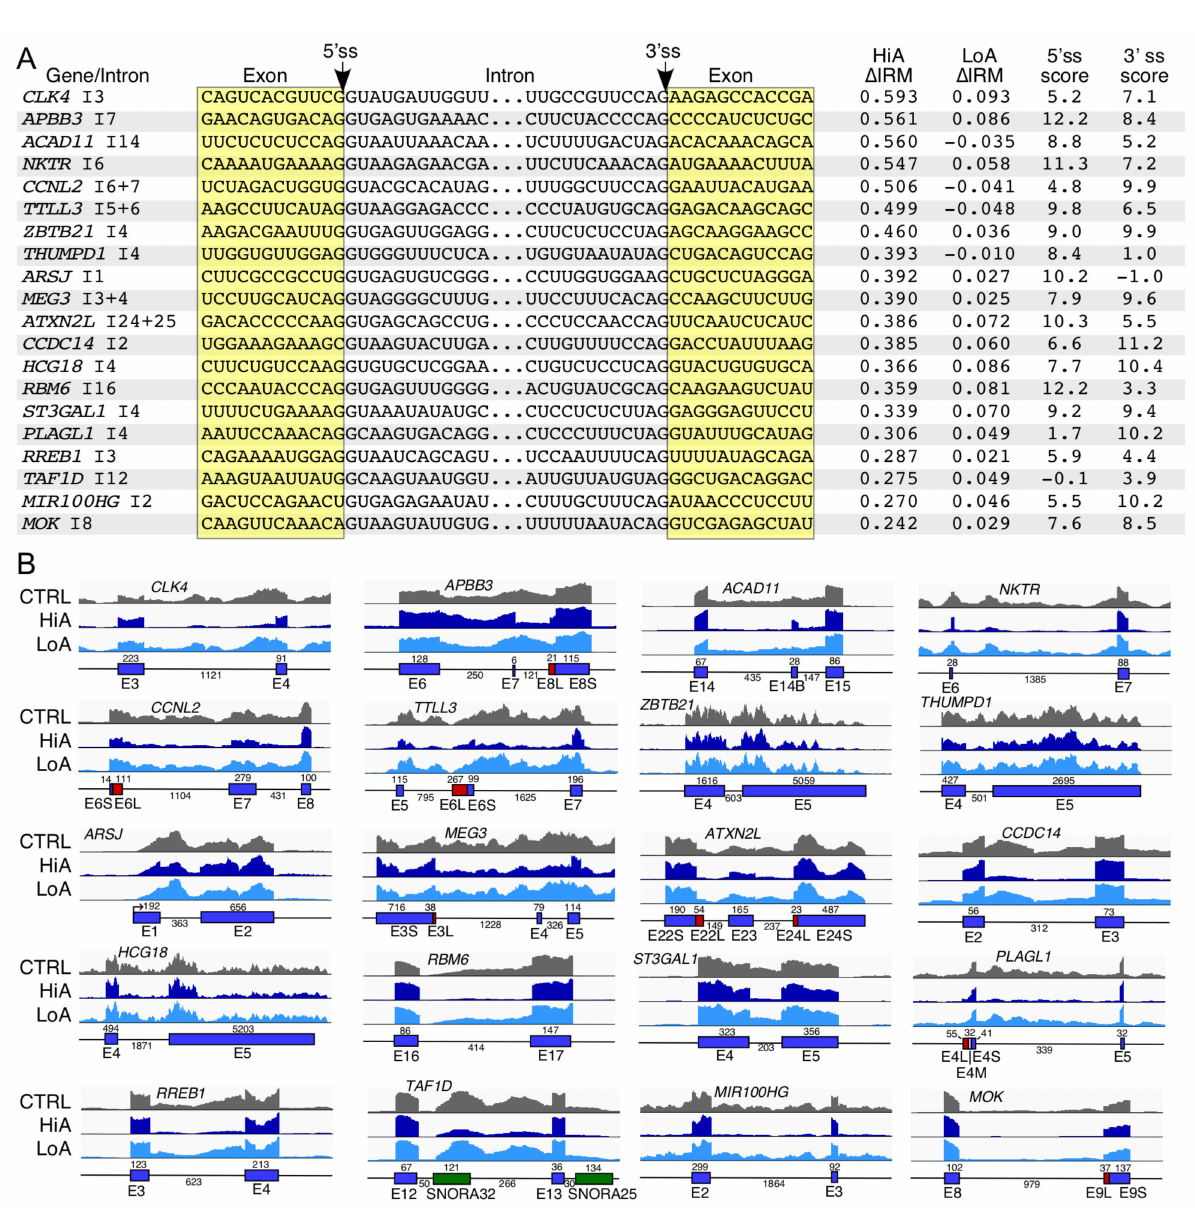
Figure 6. Increased intron removal caused by Anti-N1 treatment. ( A ). The sequence context of 20 candidate introns exhibiting greatly increased removal upon Anti-N1 treatment; 12 nucleotide-long sequences upstream and downstream of each indicated splice site of the affected introns are shown. ∆ IRM indicates the change in proportional intron removal vs. intron retention. Other table contents and annotation are the same as in Figure 3A. ( B ). Genomic views of several candidate introns with increased removal after Anti-N1 treatment. In exons with 3 alternative 5 (cid:48) or 3 (cid:48) ss, the intermediate region is colored pink. Other labeling and coloring are the same as in Figure